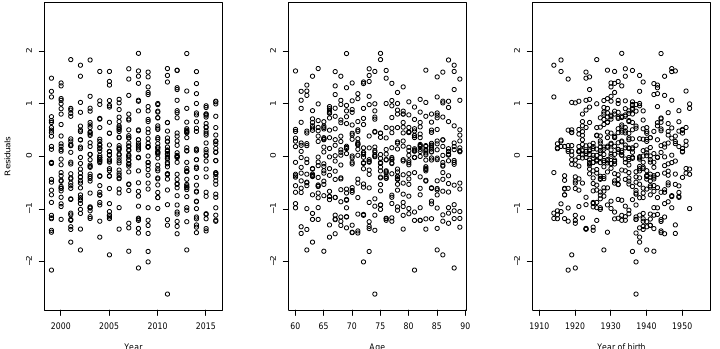
Figure 9. RH–LC deviance residuals for the female Maltese population.